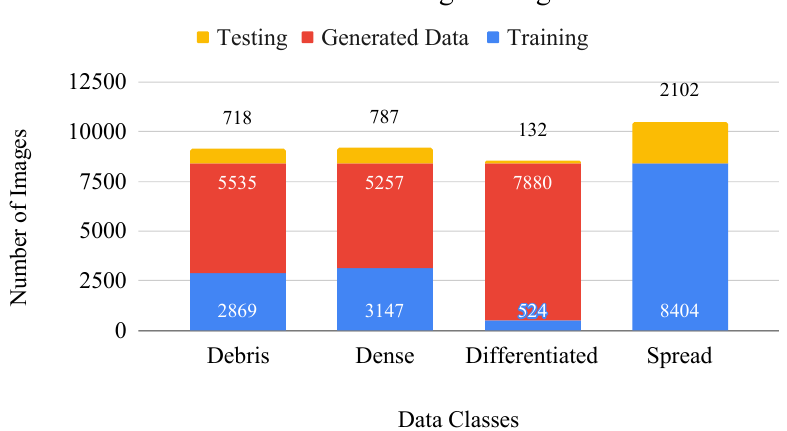
Figure 4. Bar graph of data breakdown including values for training/testing (blue/yellow) split. Generated images (red) are added to the dataset to make up for class imbalances during CNN